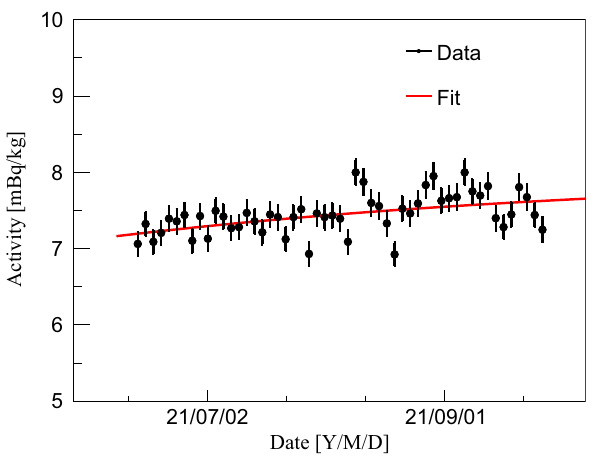
Fig. 12 Total alpha rates in the NEO-2 crystal as a function of time are modeled with 210 Po assuming a contamination of 222 Rn (and/or 210 Pb) of approximately 20 NPE/keVee owing to the development of cracks because of the initial polishing process.